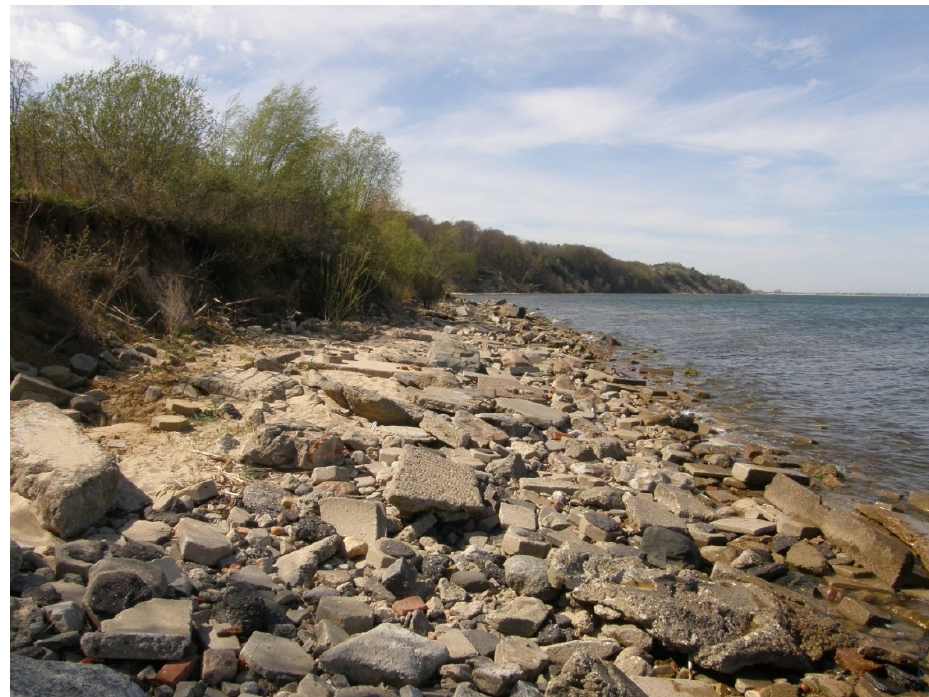
Figure 2. Revetment on the seashore in the region of Babie Do ł y (KM 93.6–93.9).